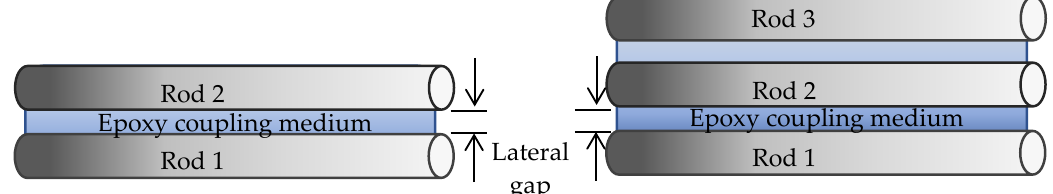
Figure 1. Schematic of the two- and three-rods experimental systems. The rods are composed of aluminum and are elastically coupled with epoxy.